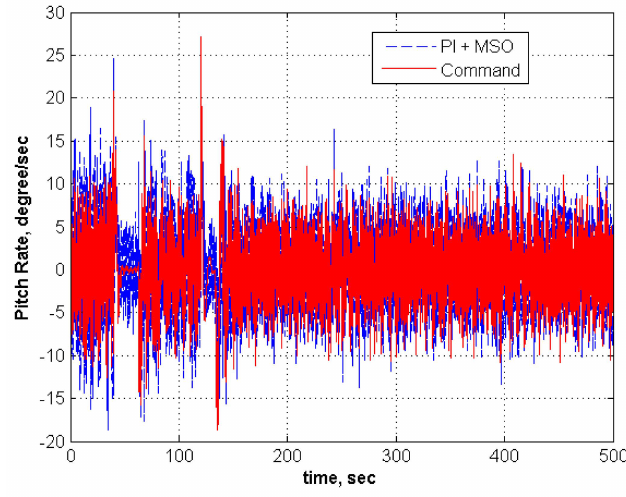
Figure 6. Pitch rate response for 100% C m α